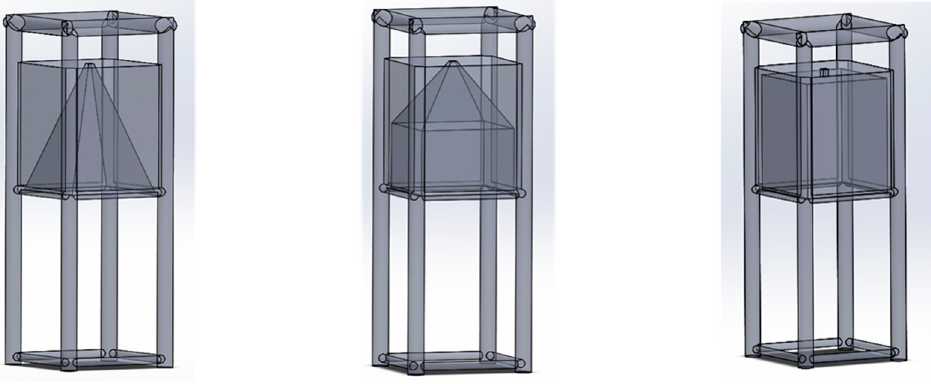
Figure 4. Consideration for various shapes of air-chamber of the OWC wave energy converter installed in an offshore template structure.